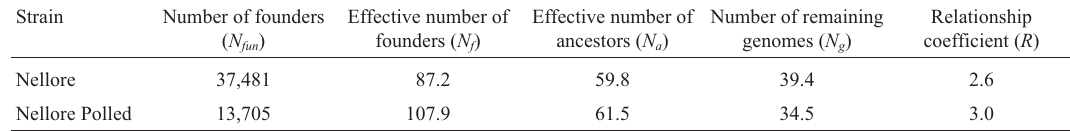
Table 1 - Genetic variability in Nellore and polled Nellore strains after pedigree analysis.